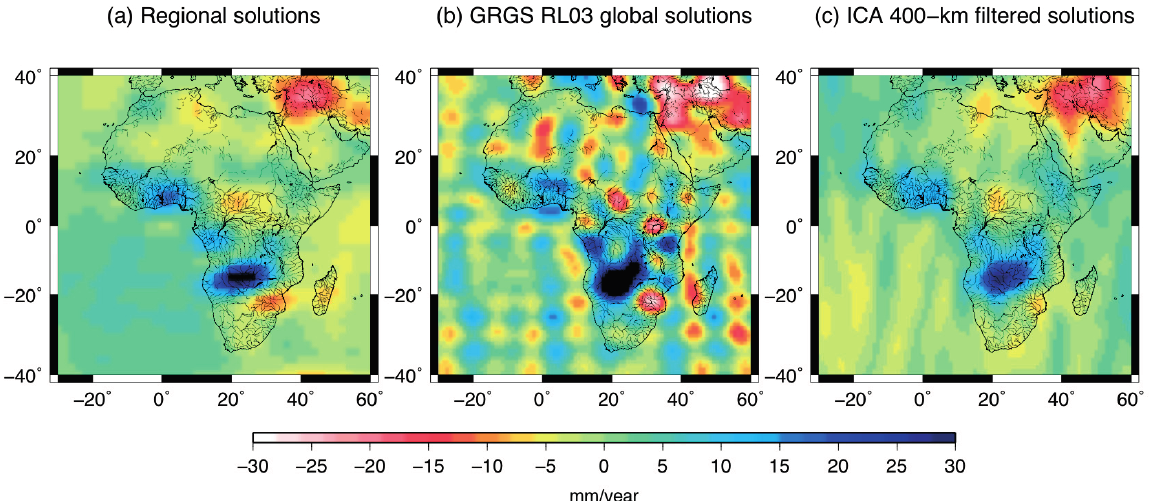
Figure 6. Maps of the linear trends of the water mass changes by fitting a linear trend for each grid cell from all of the 10-day regional solutions over Africa for 2003–2012: ( a ) Regional solutions; ( b ) GRGS RL03 global solutions; ( c ) ICA 400-km filtered solutions; ( d ) TRMM Precipitation 2003–2012. Units are mm of EWH per